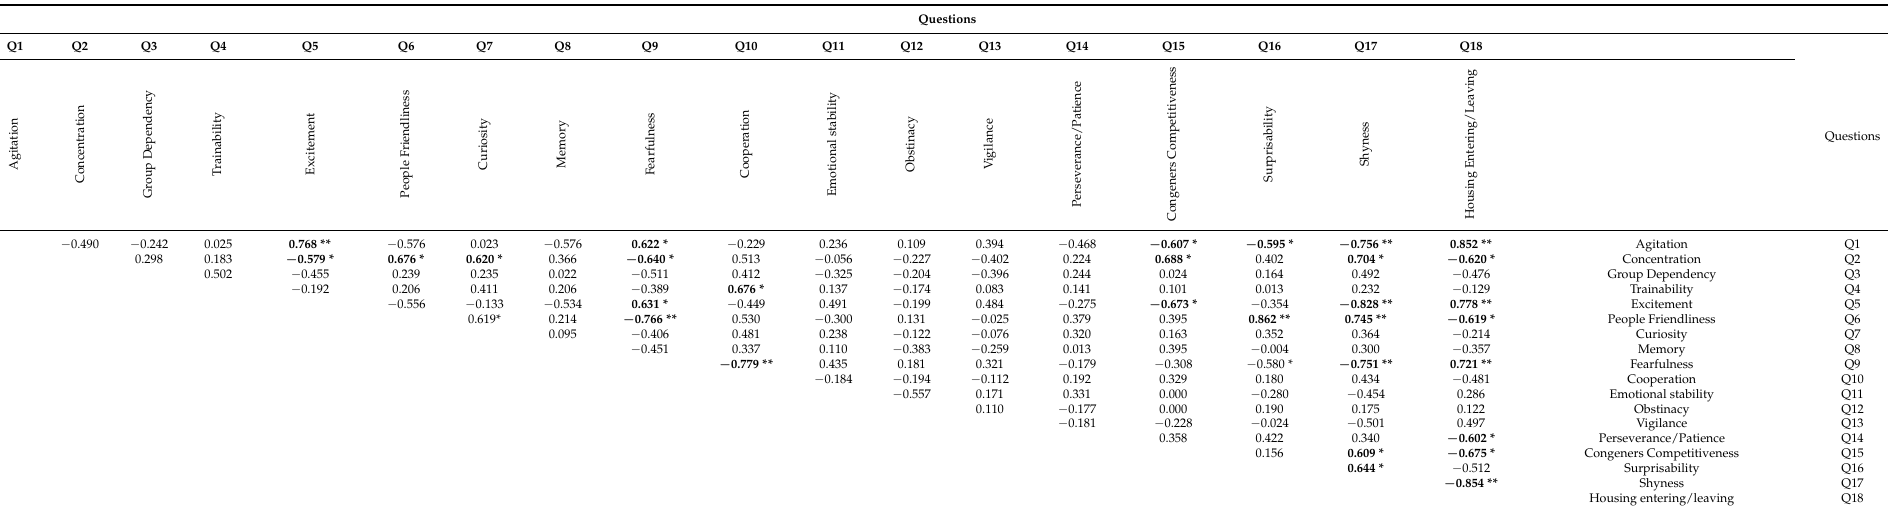
Table 2. Spearman’s correlation coefficients (rs) between questions of the personality questionnaire (Q1–18). Scores for each question were calculated as the average between all individual scores (mean score of the ten observers), n = 121